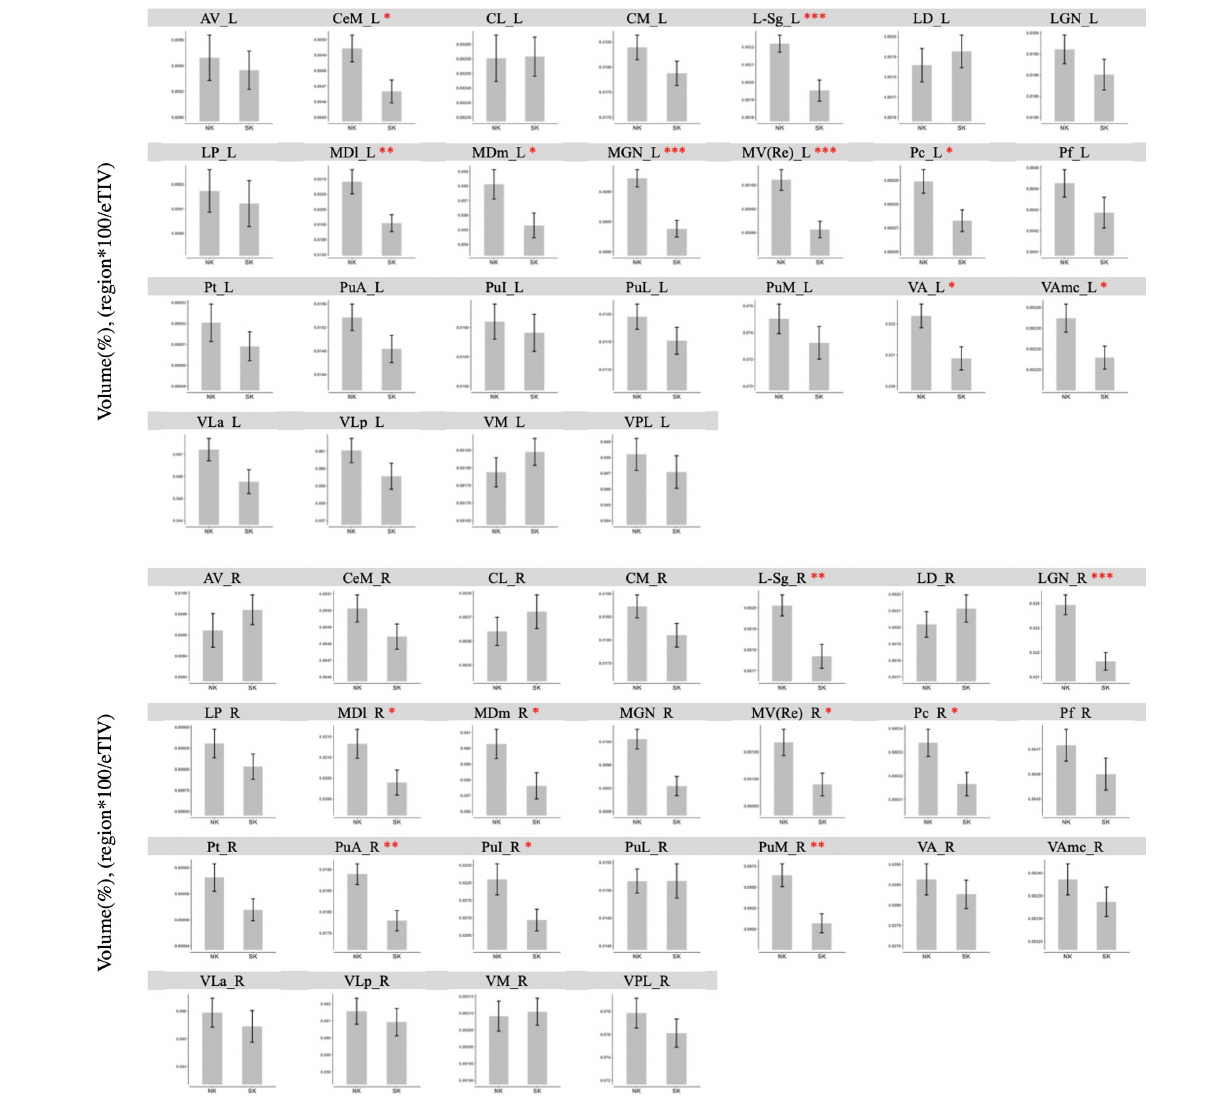
FIGURE 2 | Comparison of gray matter volume of thalamic nuclei between NK refugees and SK residents in additional analysis using Freesurfer. In the direct thalamic nuclei segmentation using Freesurfer, NK refugees showed greater GM volumes in the left central medial, suprageniculate, mediodorsal lateral parvocellular, mediodorsal medial magnocellular, medial geniculate, reuniens, paracentral, ventral anterior, ventral anterior magnocellular nucleus and right suprageniculate, lateral geniculate, mediodorsal lateral parvocellular, mediodorsal medial magnocellular, medial geniculate, reuniens, paracentral, pulvinar anterior, pulvinar inferior, pulvinar medial nucleus than SK residents. ∗ p < 0.05, ∗∗ p < 0.01, ∗∗∗ p < 0.001. AV, Anteroventral; LD, Laterodorsal; LP, Lateral posterior; VA, Ventral anterior; VAmc, Ventral anterior magnocellular; VLa, Ventral lateral anterior; VLp, Ventral lateral posterior; VPL, Ventral posterolateral; VM, Ventromedial; CeM, Central medial; CL, Central lateral; Pc, Paracentral; CM, Centromedian; Pf, Parafascicular; Pt, Paratenial; MV-re, Reuniens (medial ventral); MDm, Mediodorsal medial magnocellular; MDl, Mediodorsal lateral parvocellular; LGN, Lateral geniculate; MGN, Medial Geniculate; L-sg, Limitans (suprageniculate); PuA, Pulvinar anterior; PuM, Pulvinar medial; PuL, Pulvinar lateral; PuI: Pulvinar